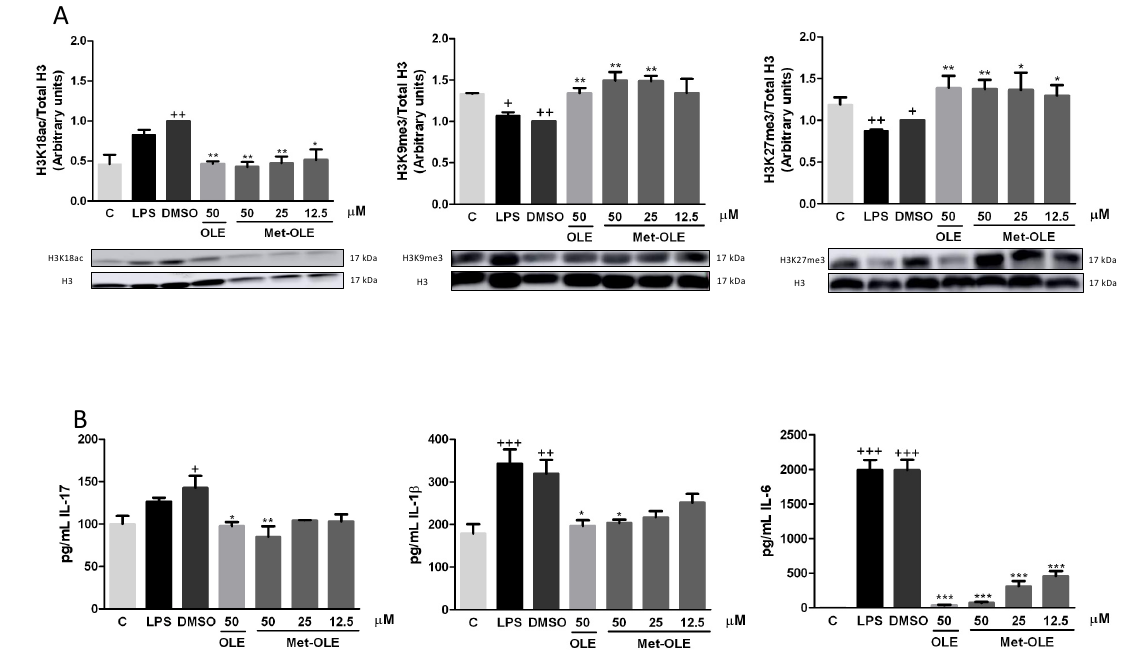
Figure 7. ( A ) Epigenetic modifications of histones by OLE and met-OLE and ( B ) the cytokine-related response. Spleen cells were pre-treated with OLE (50 µ M) or met-OLE (50, 25 or 12.5 µ M) for 30 min and then, LPS-stimulated during an 18 h period. The histones were isolated from cells and the expression of H3 modifications was evaluated using antibodies for H3K18ac, H3K9me3 and H3K27me3 by Western blot. Related cytokine levels were measured in cell supernatants using specific ELISA assays. Results are presented as the mean ± SEM of at least six independent experiments. + p < 0.05; ++ p < 0.01; +++ p < 0.001 vs. unstimulated cells; * p < 0.05; ** p < 0.01; *** p < 0.001 vs. LPS-DMSO stimulated cells.